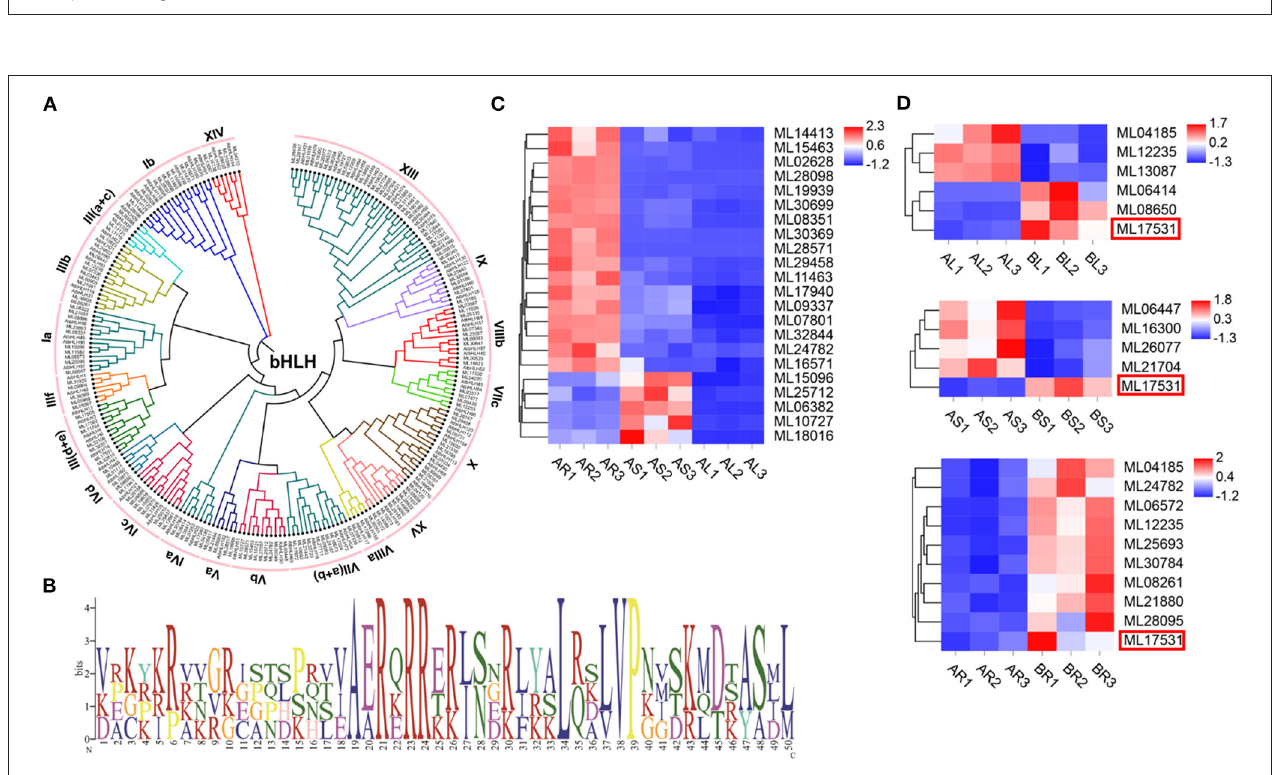
FIGURE 6 | The basic helix-loop-helix (bHLH) in S. cusia genome. (A) Phylogenetic tree of bHLH based on the protein sequence alignments from S. cusia and Arabidopsis using MEGA X with the neighbor-joining methods. (B) Logo showed the conserved amino acid residues within motif. (C) bHLH gene members with significantly up and downregulated expression in leaf and stem relative to root. (D) bHLH gene members with significantly upregulated and downregulated expression in leaf and stem relative to control sample.